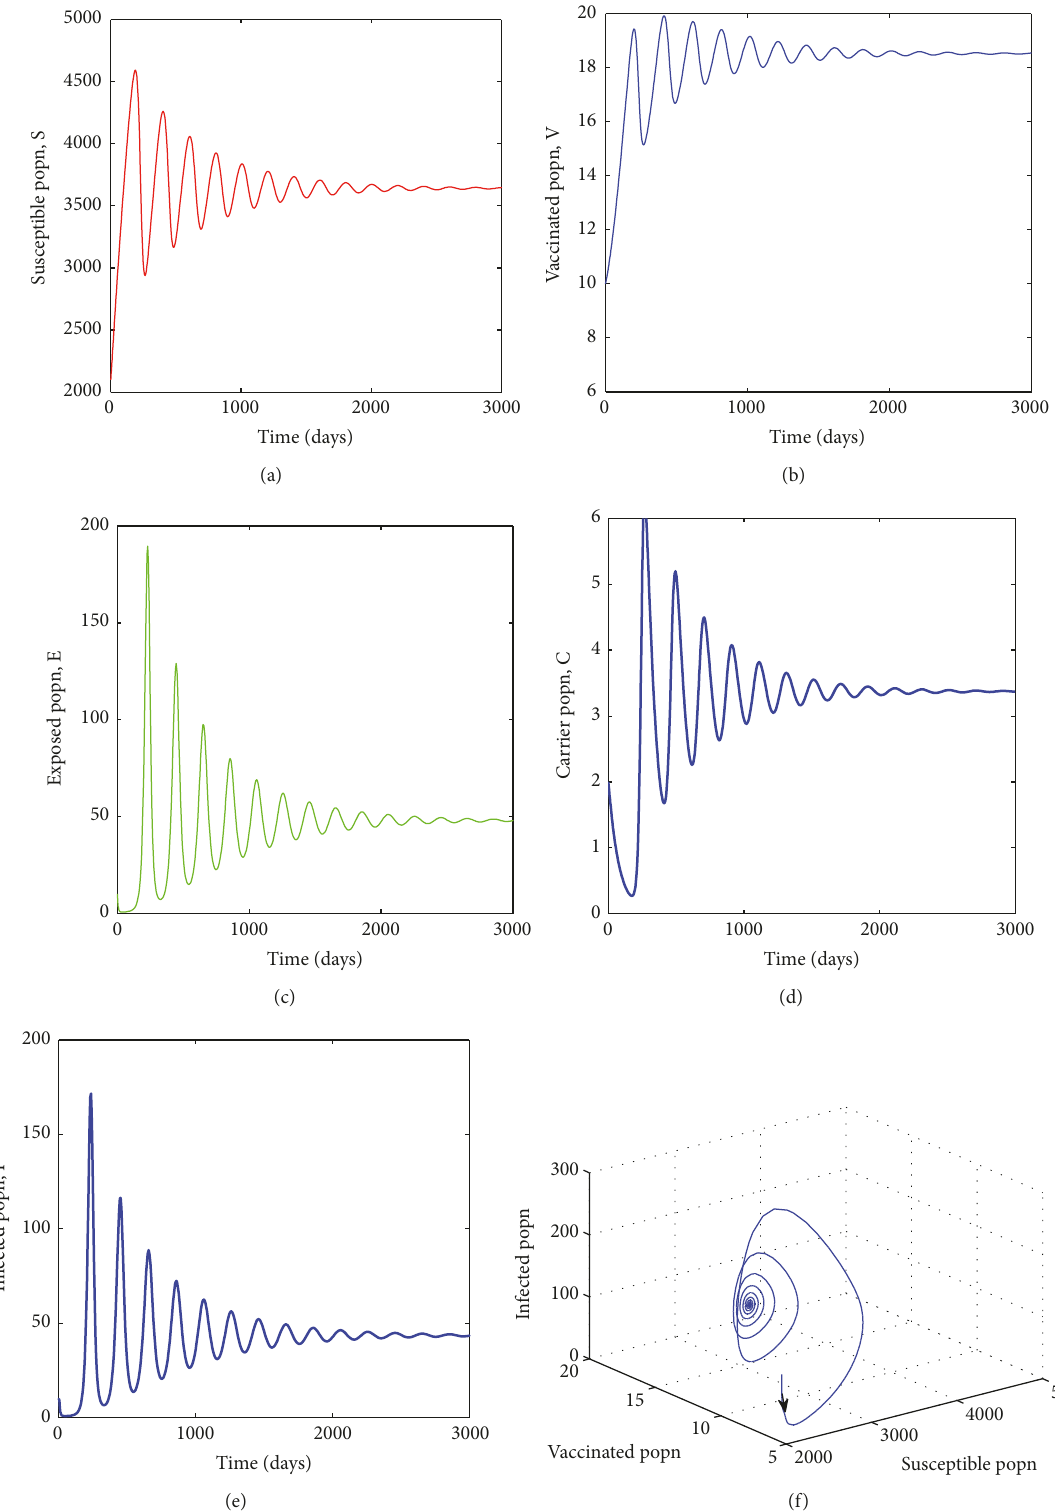
Figure 5: Stability of the endemic equilibrium 𝑃 ∗ for 𝜏 1 = 𝜏 2 = 2 days. The rest of the parameters are as in Table